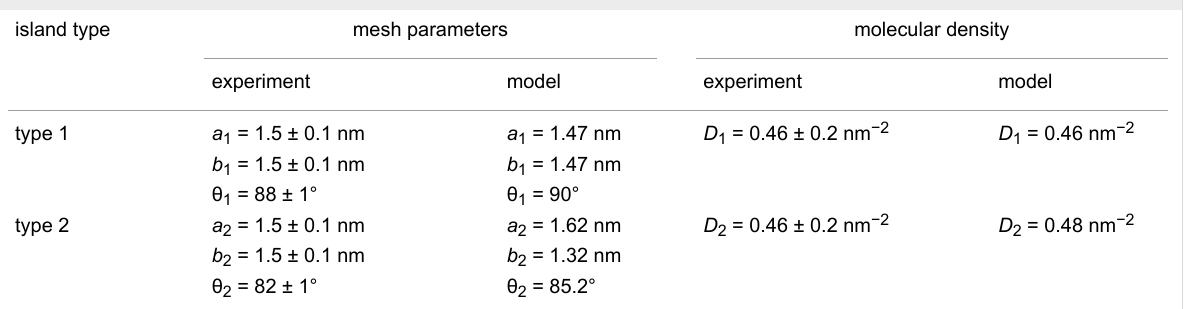
Table 1: Experimental values and model parameters of both types of Cu-TCPP islands.